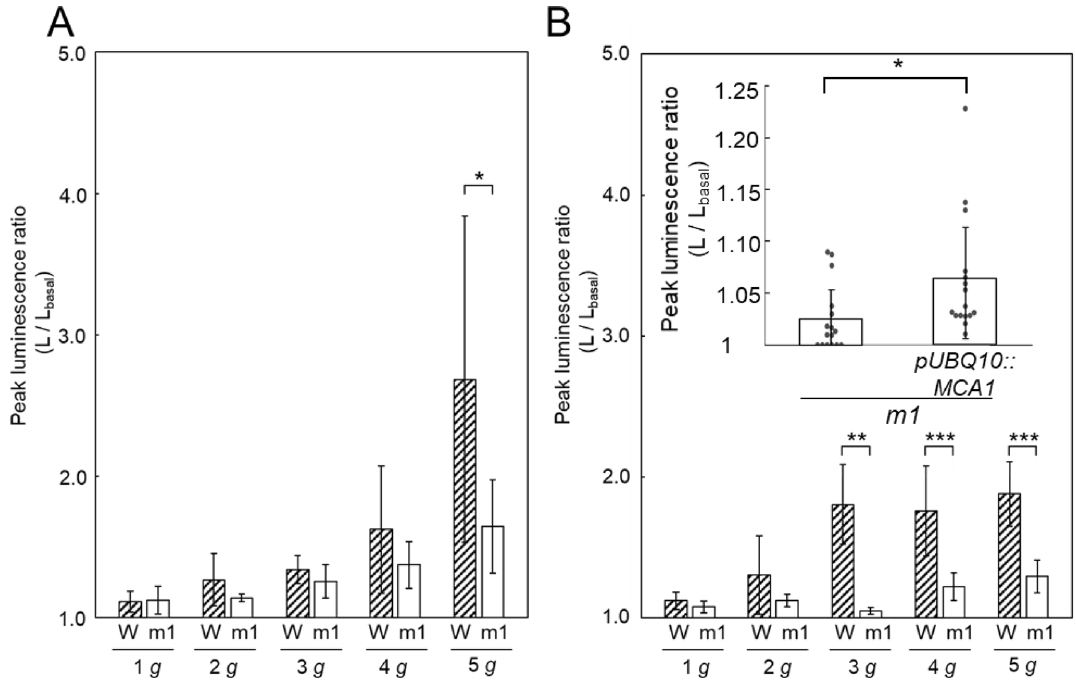
Figure 3. The peak amplitudes of the slow ( A ) and very slow [Ca 2+ ] c -increases ( B ) induced by rotations under 1–5 g. Data represent means ± SD, and two tailed Student’s test was performed. Asterisks above the bars denote significant differences between the groups, and the peak amplitude of these responses are dependent on the magnitude of gravitational acceleration (* P < 0.05, ** P < 0.01, *** P < 0.001). Letters W and m1 denote wild- type and mca1- knockout mutant seedlings, respectively. The inset in ( B ) shows the amplitude of the very slow [Ca 2+ ] c -increase under 3 g conditions in an mca1- knockout mutant (left) and MCA1 -complemented mutant (right) ( n =